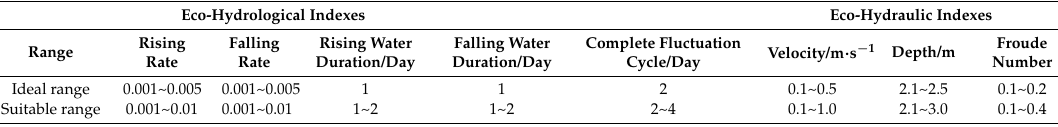
Table 2. Habitat characteristic index ranges for S. younghusbandi spawning